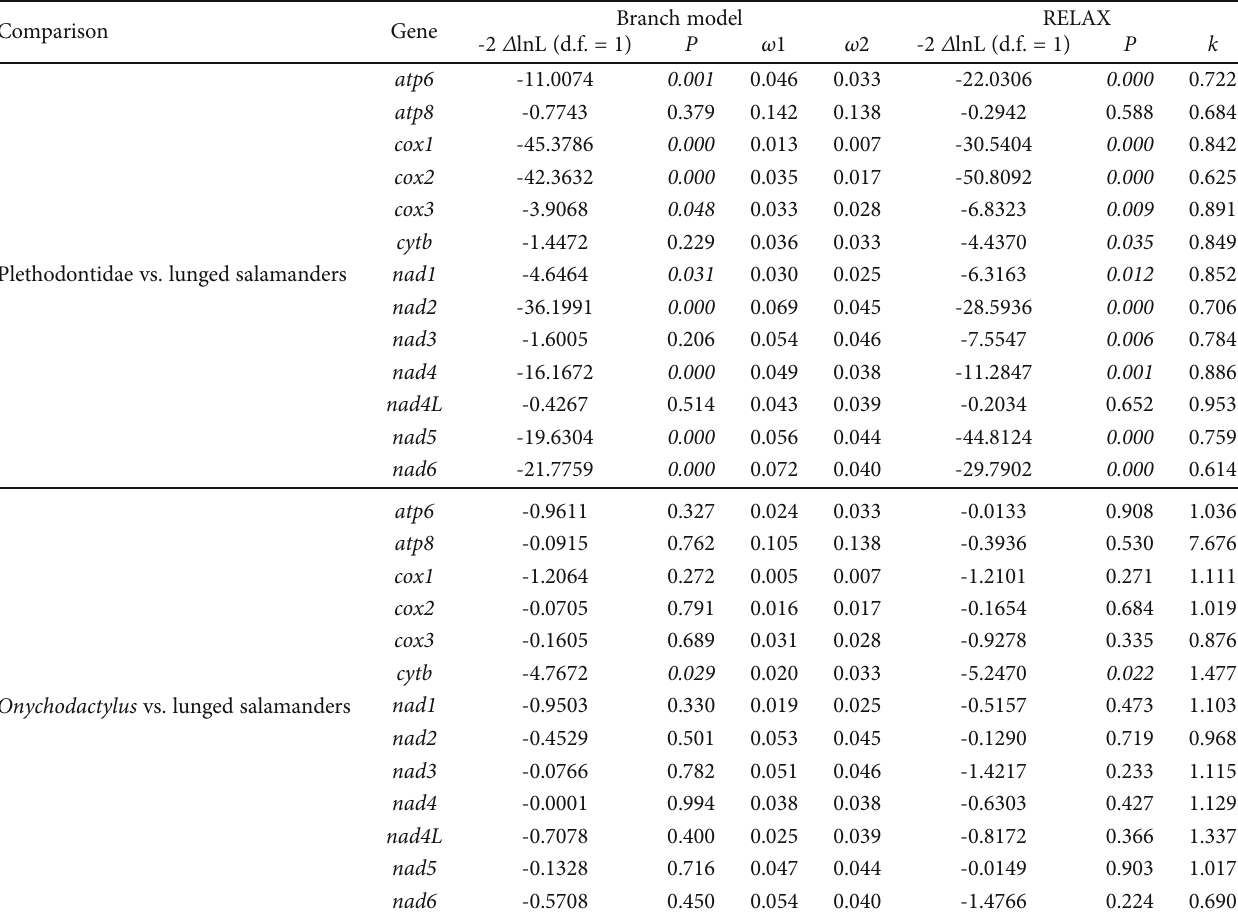
Table 1: Results of branch model and RELAX analyses of mitochondrial genes with internal branches.